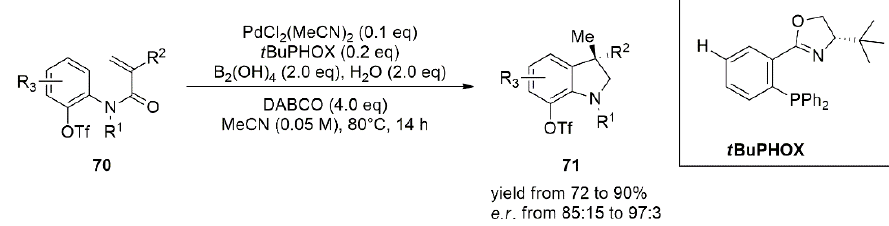
Figure 31. Asymmetric intramolecular reductive Heck reaction of N -aryl acrylamides ( 70 ).